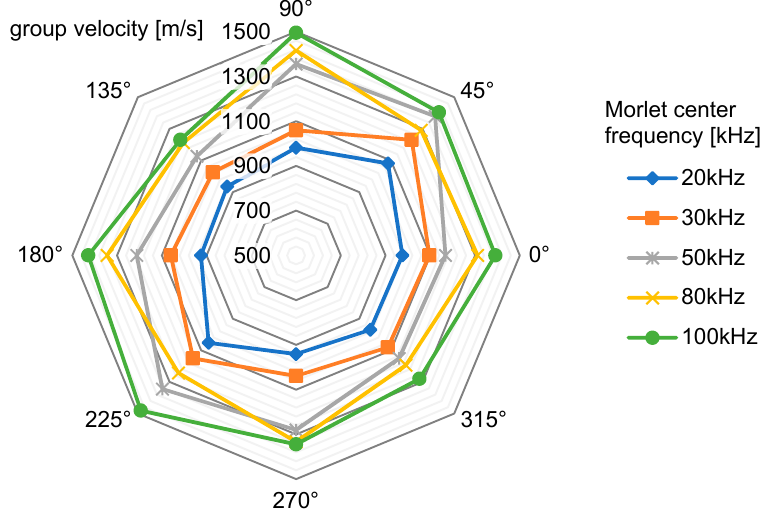
Figure 5. Group velocity measurements for anti-symmetric mode A 0 on the test plate.